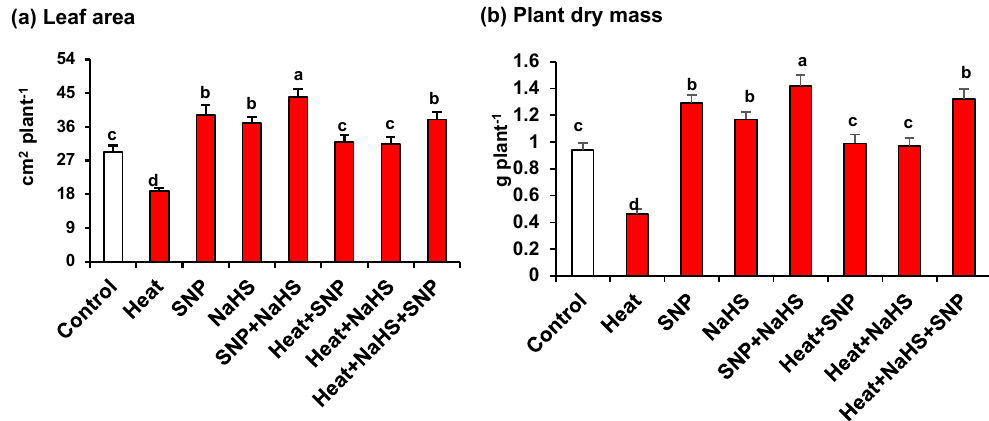
Figure 1. ( a ) Leaf area and ( b ) plant dry mass in wheat ( Triticum aestivum L. var. WH 542) leaves treated with SNP (100 µM) and/or NaHS (200 µM) in the presence (40 °C) or absence (25 °C) of heat stress at 30 days after sowing (DAS). Data are presented as treatments mean ± SE ( n = 4). Data followed by the same letter are not significantly different by least significant difference (LSD) test at ( p < 0.05). SNP, sodium nitroprusside; NaHS, sodium hydrosulfide.